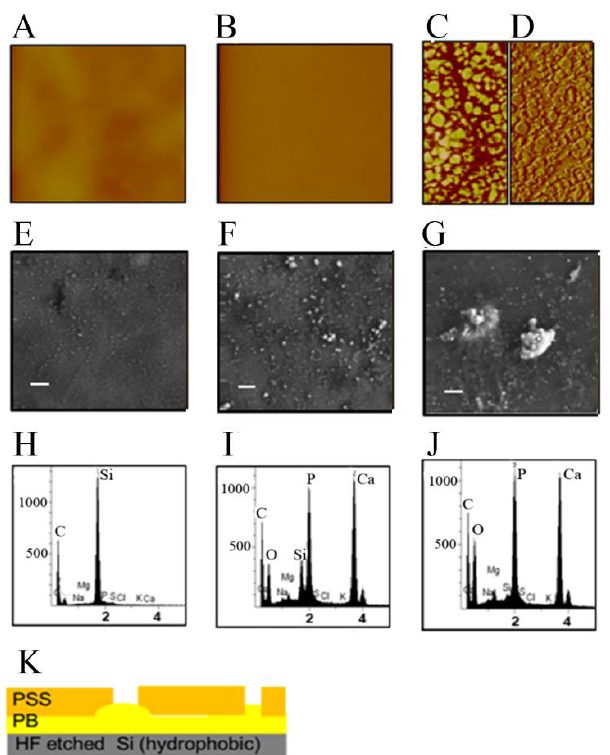
Figure 5. ( A ) SEM image of biomineralized film deposited by the C9 cells after 14 days in culture on PSS28, clearly showing the ECM fibers. ( B ) EDX spectra of the film showing the presence of Ca, P, O, and Si minerals present. ( C – E ) Elemental maps of Ca, P, and Si on the surface with overlap of Ca and P consistent with a uniform layer of hydroxyapatite incorporated into the ECM fibers shown in ( A ).